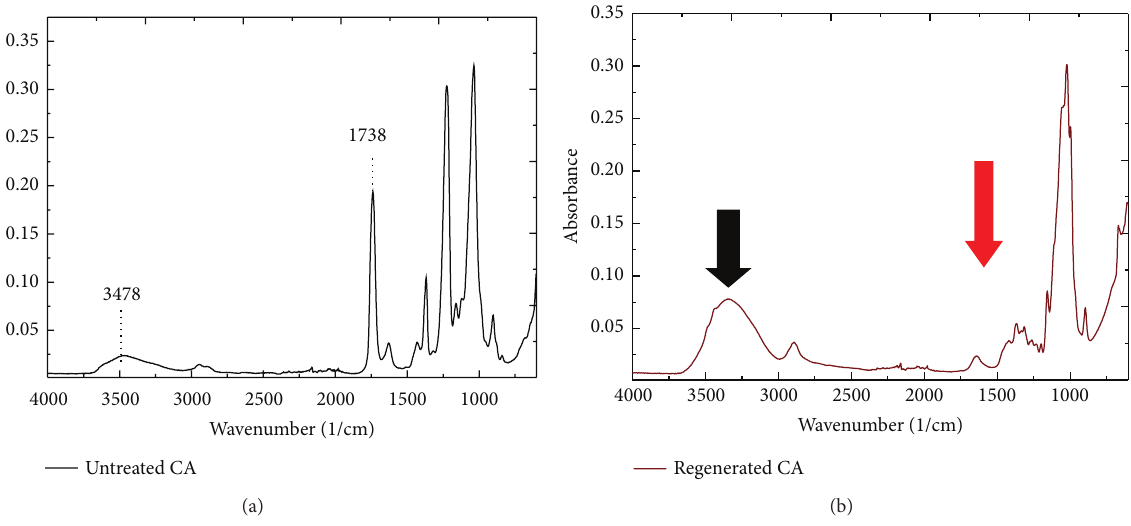
Figure 9: ATR-FTIR spectra of the electrospun CA fibre webs (a) CA web and (b) regenerated Cellulose web.